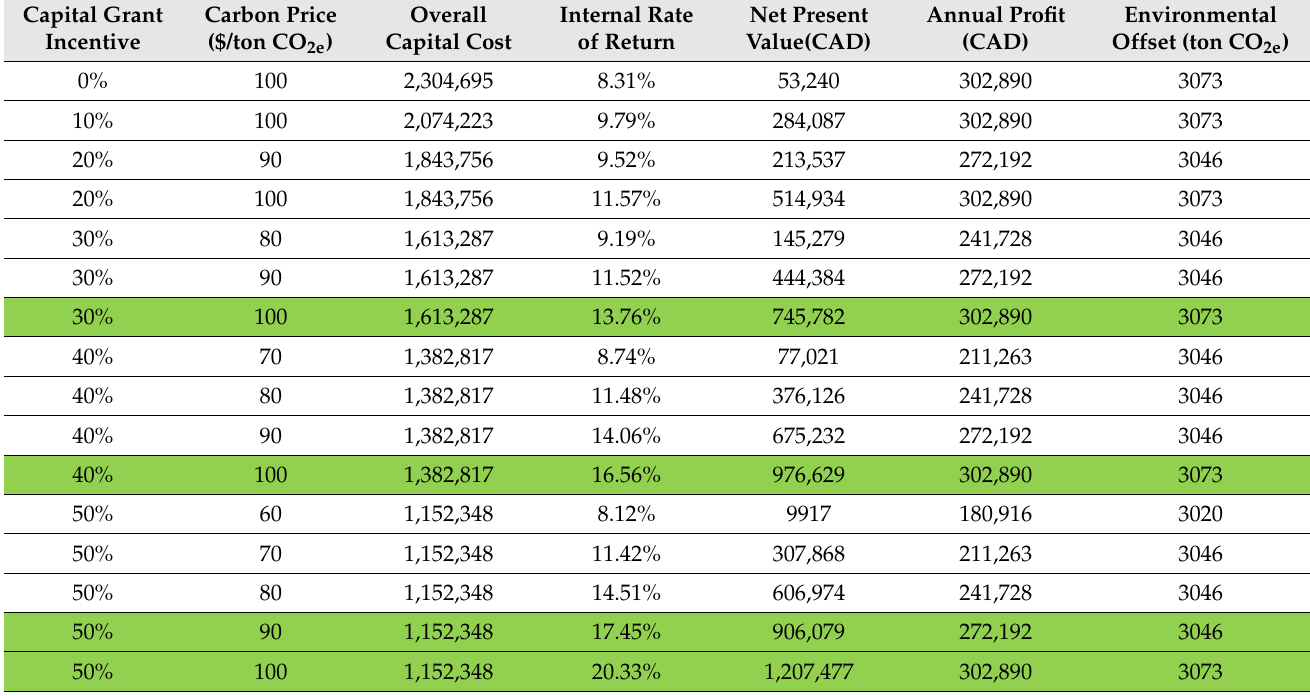
Table 1. Feasible solutions (shown in green) to the simulation showing favorable economics under carbon prices greater than 60$/ton CO 2e . CAD-Canadian